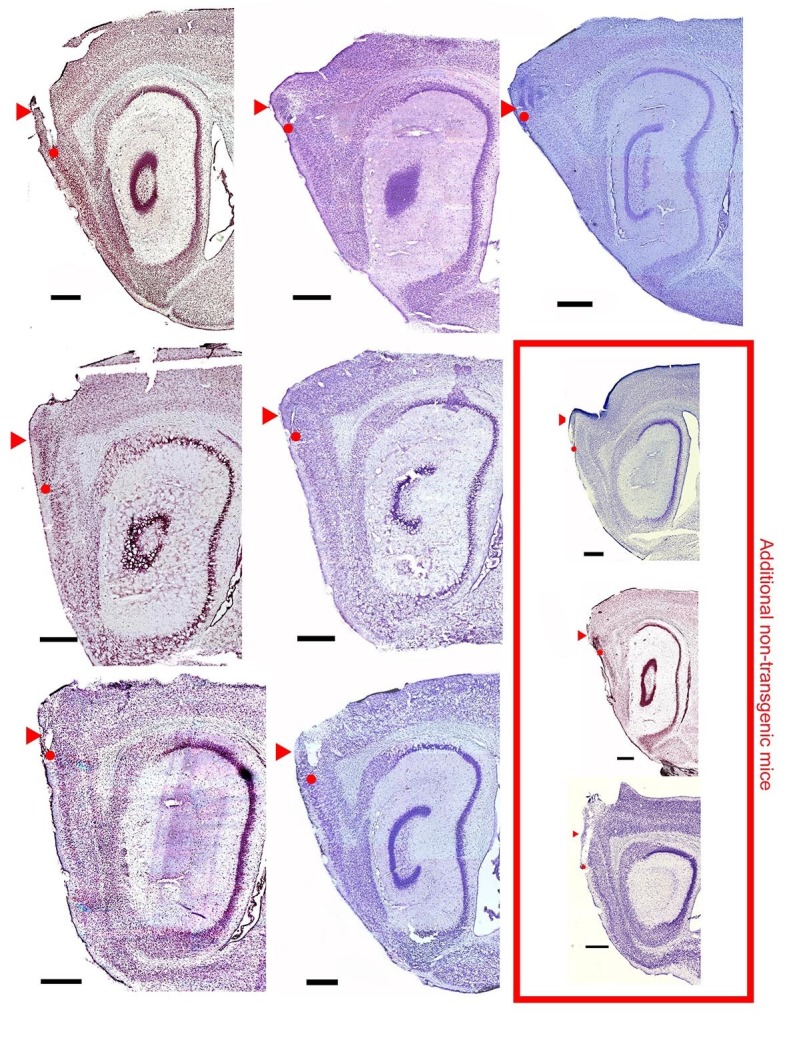
Nissl-stained saggital brain sections showing recording locations for seven EC-tTA x tetO-ArchT-GFP mice used in the study and three additional wild-type animals used in the extended layer II dataset.Triangle shows the dorsal extent of MEC and dots show the final recording locations. Scale bars are 500 microns.